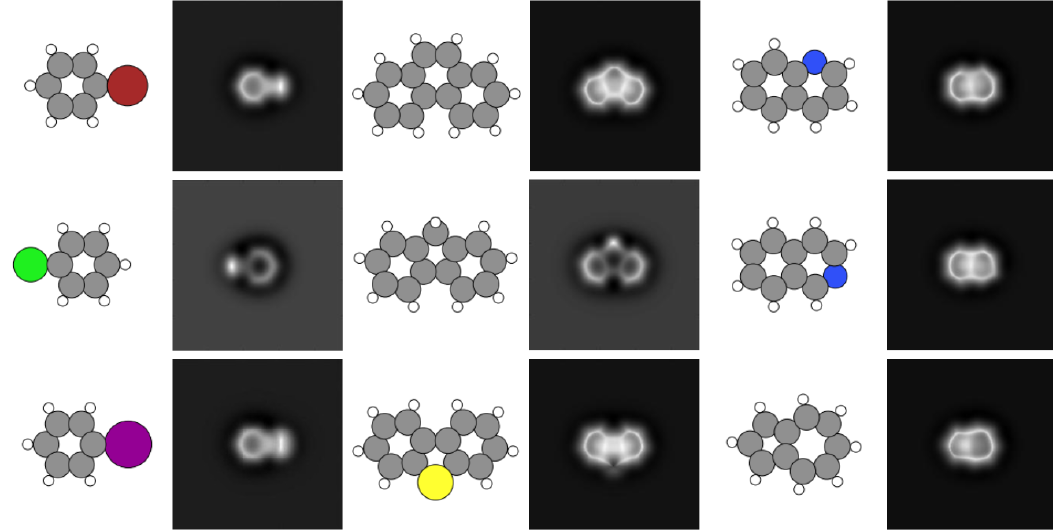
Figure 2. Theoretically simulated AFM images for different molecules. Each column displays three molecular structures that give rise to very similar AFM images, making it extremely difficult for a human to identify them. Atoms are represented with the same color code used in Figure 1.